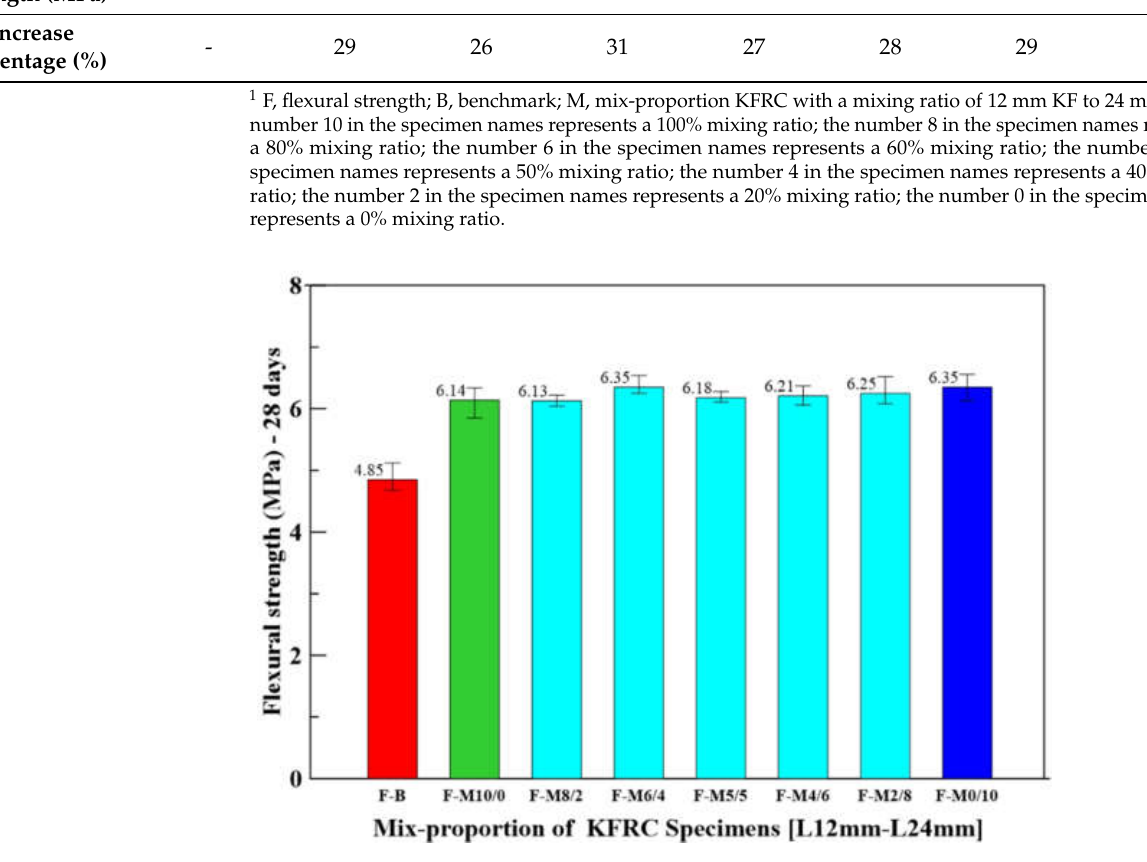
Figure 8. Flexural strengths of the benchmark and mix-proportion KFRC specimens.